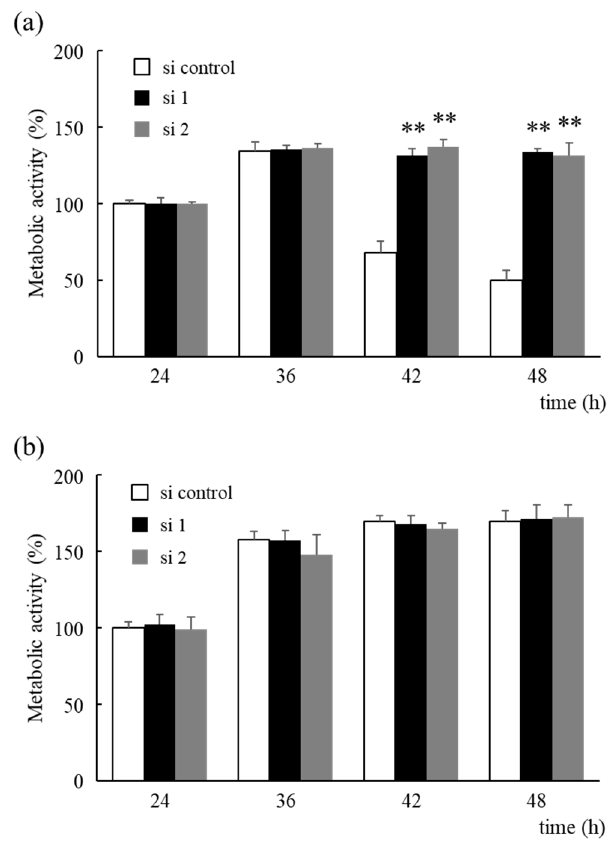
Figure 4. Alterations in metabolic activity due to HNRNPM knockdown under low-glucose condi- tions. ( a , b ) Cells were pre-treated with an siRNA against HNRNPM or a non-targeting siRNA and incubated for 24 to 48 h. Metabolic activity was determined using the Cell Counting Kit-8 assay under low-glucose ( a ) or high-glucose conditions ( b ). Data are shown as mean ± SD (n = 3); **, p < 0.01 compared to each si control. si control: non-targeting siRNA-transfected cells, si 1: HNRNPM siRNA (SASI_Hs01_00049126)-transfected cells, and si 2: HNRNPM siRNA (SASI_Hs01_00049128)-transfected cells.